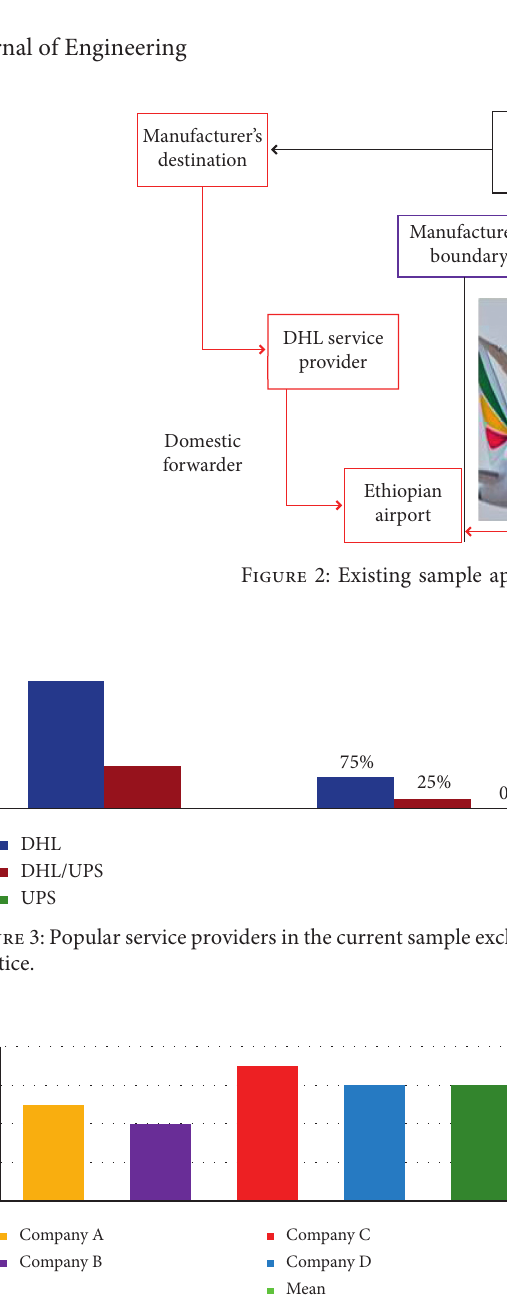
Figure 4: Average lead time for sample arrival at the buyer’s